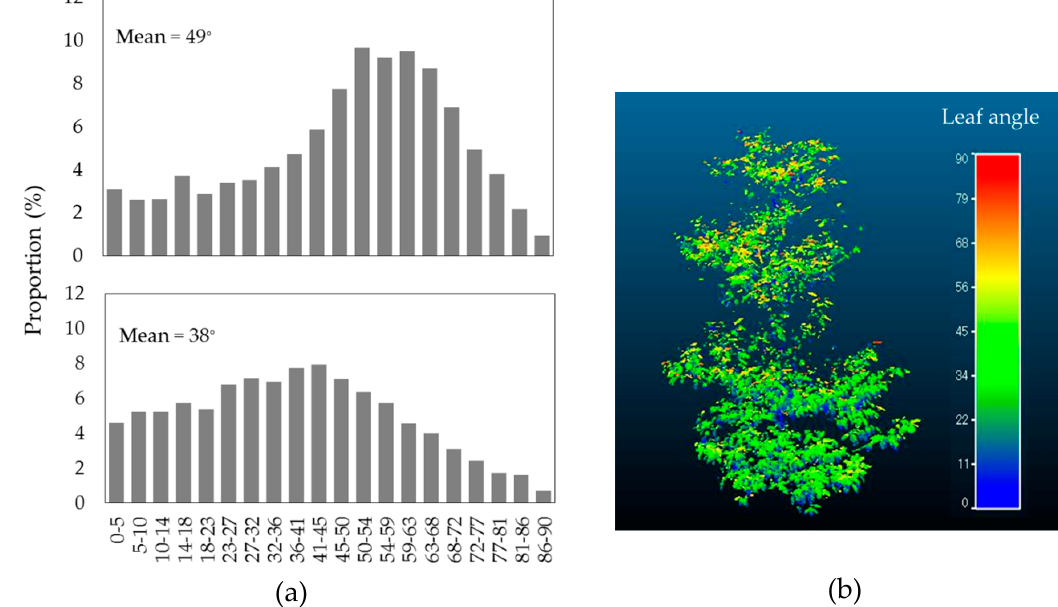
Figure 9. Leaf angle distribution (LAD) in the Japanese camellia: ( a ) LAD graph for the tree’s top (4.5–2.3 m) and bottom (2.3–0 m); ( b ) LAD image of the whole tree.